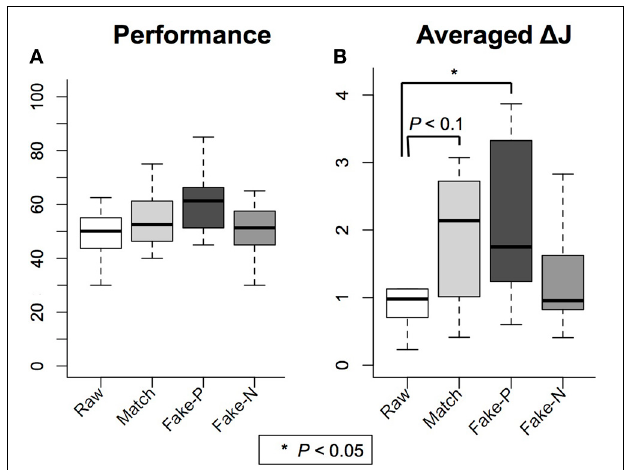
FIGURE 4 | Results for experiment 2 (A) Mean value of subjects’ performances in the second half of each session is demonstrated. No significant difference was found. (B) Mean value of the ratio J 2 / J 1 , an identifier of motor imagery quality, showed significantly higher values in the Fake-P and Match conditions compared to